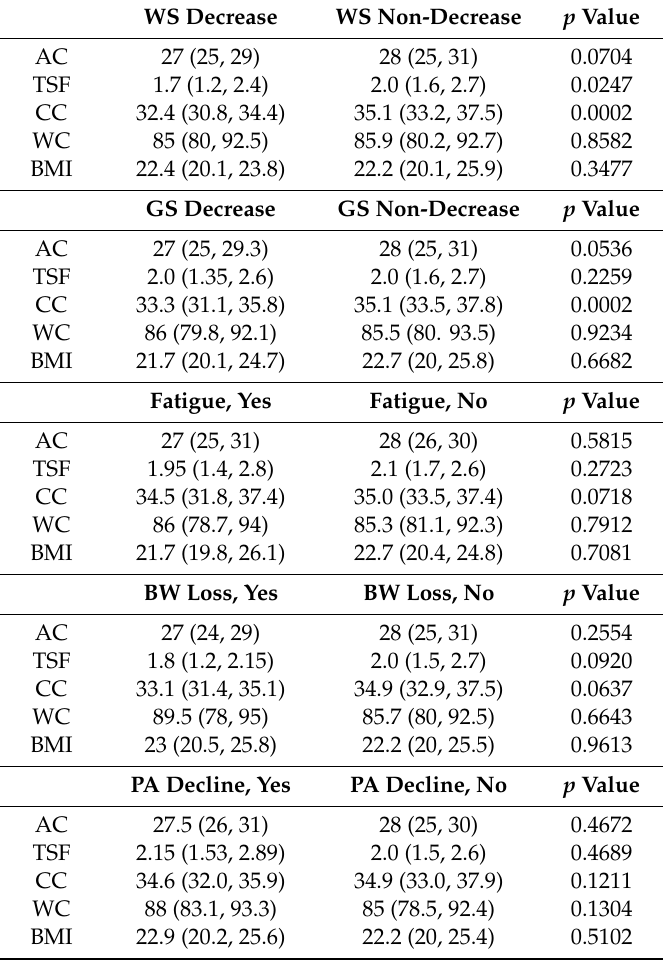
Table 3. Anthropometric measurements according to the frailty phenotypes in female